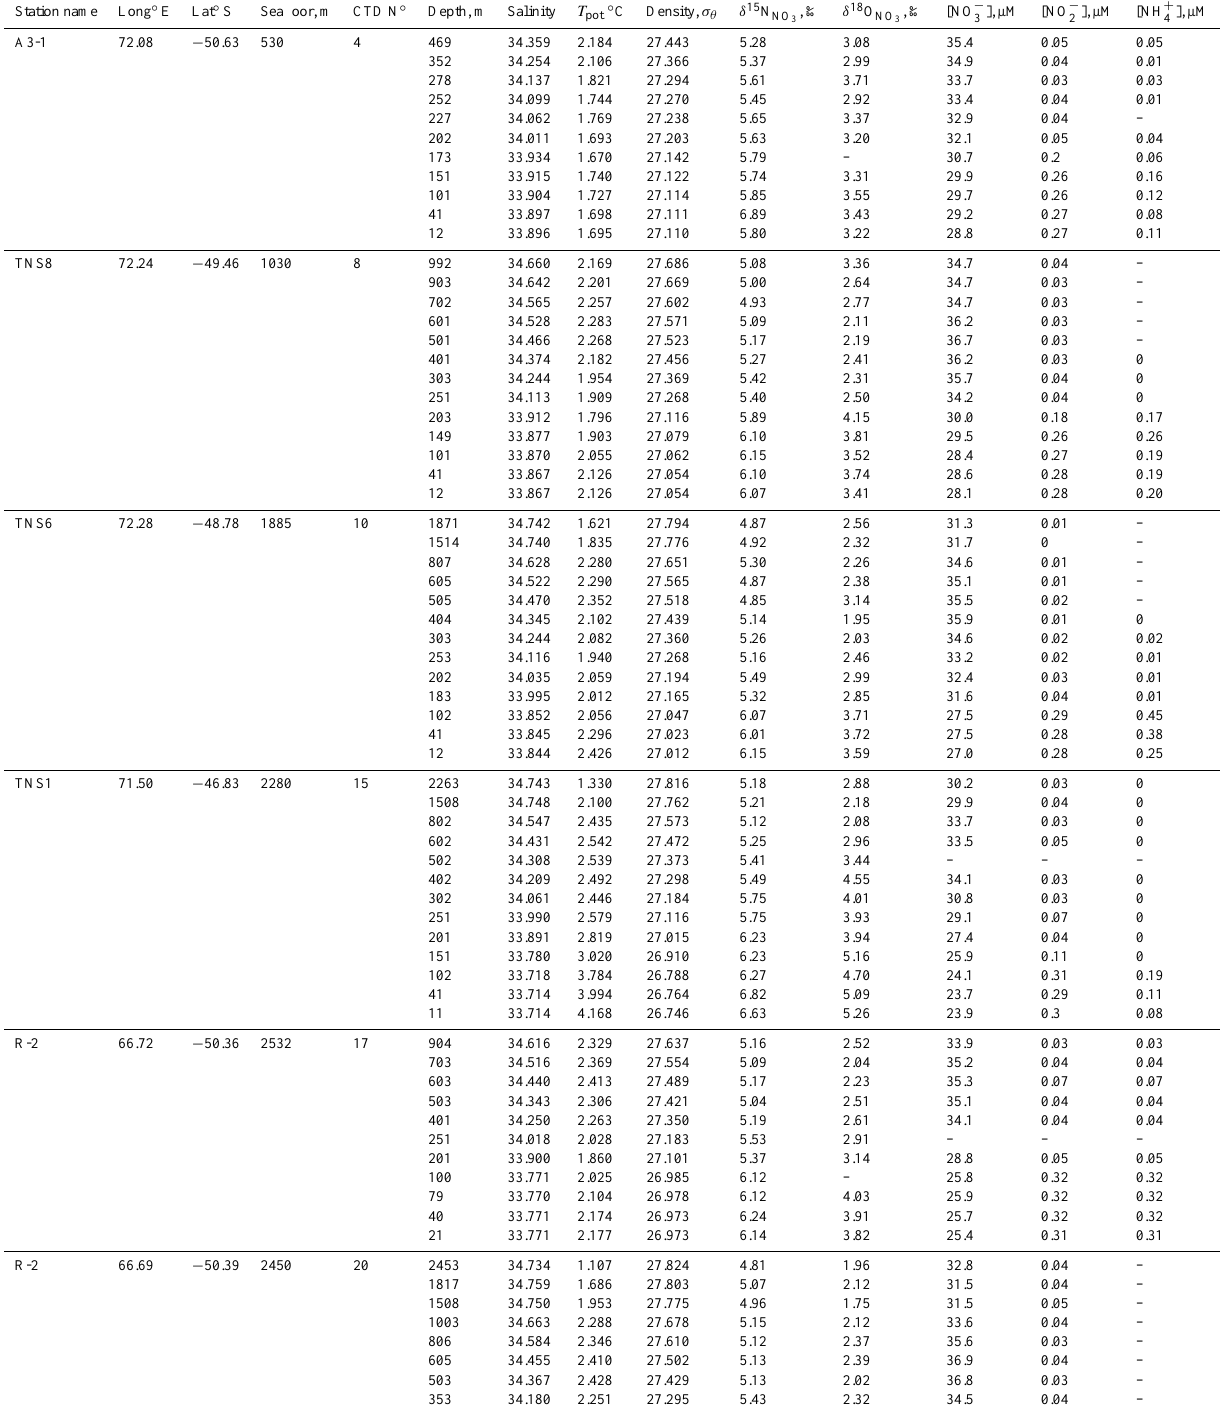
Table A1. Complete data set. Salinity, Tpot, density, δ 15 N NO3 , δ 18 N NO3 , concentrations of NO − from Blain et al.